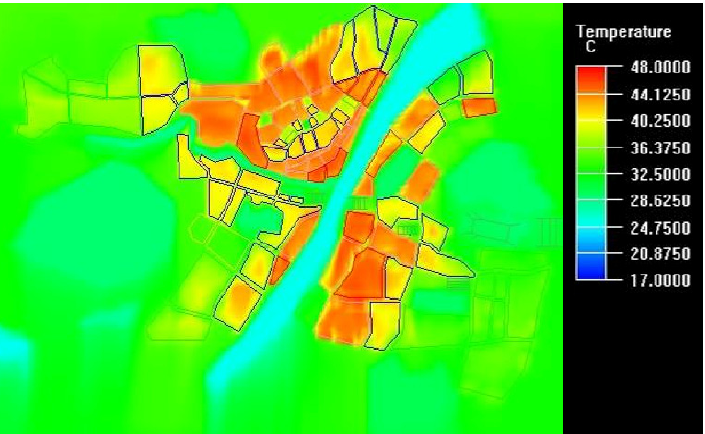
Figure 4. City heat environment simulation of Wuhan